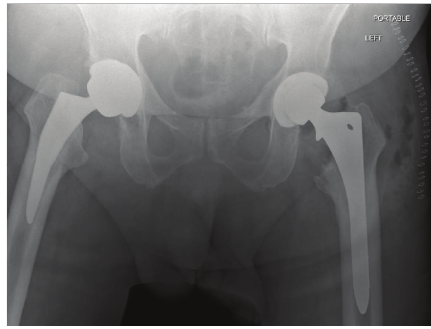
Figure 4: AP pelvis postoperatively showing good alignment without fracture or femoral cortex perforation.